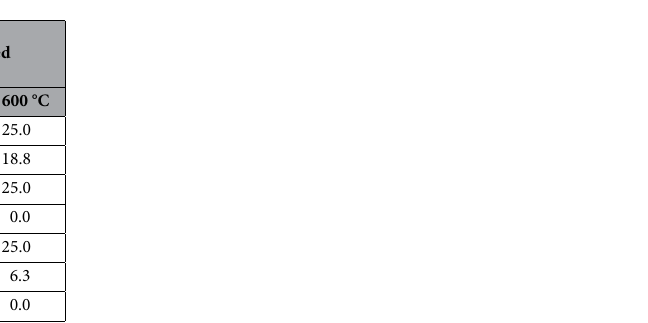
Table 6. Relative frequency of coefficient of variation (in %) for loose and dense compacted